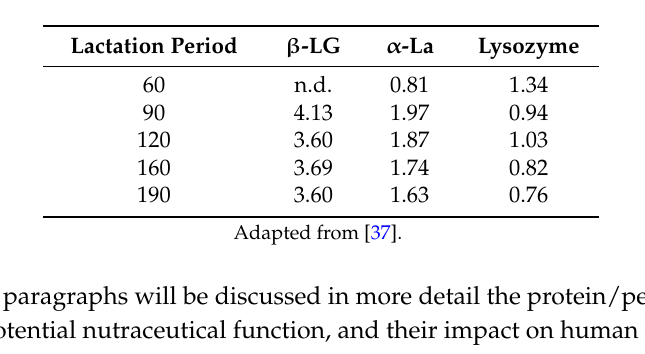
Table 6. Content (g/L) of lysozyme, β -LG and α -La in donkey milk collected in different stages of